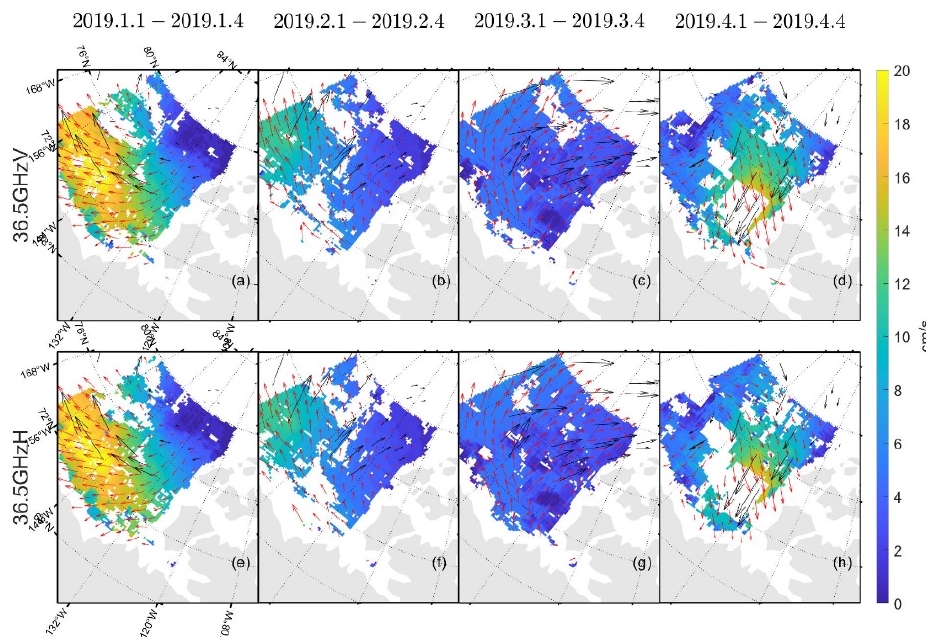
Figure 5. Schematic diagram of the movement of sea ice retrieved by FY ‐ 3D/MWRI T b data at 36.5 GHz . Figure ( a )–( d ) show sea ice motion retrieved from FY ‐ 3D/MWRI T b data at 36.5 GHz with V polarization. Figure ( e )–( h ) show sea ice motion retrieved from FY ‐ 3D/MWRI T b data at 36.5 GHz with H polarization.